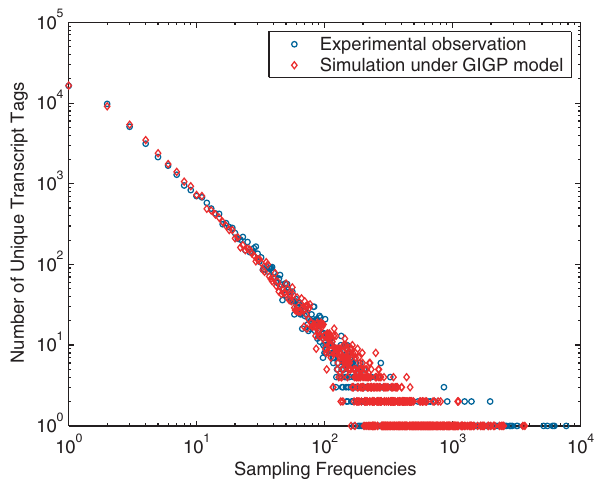
Table 2. Distribution of expression level.